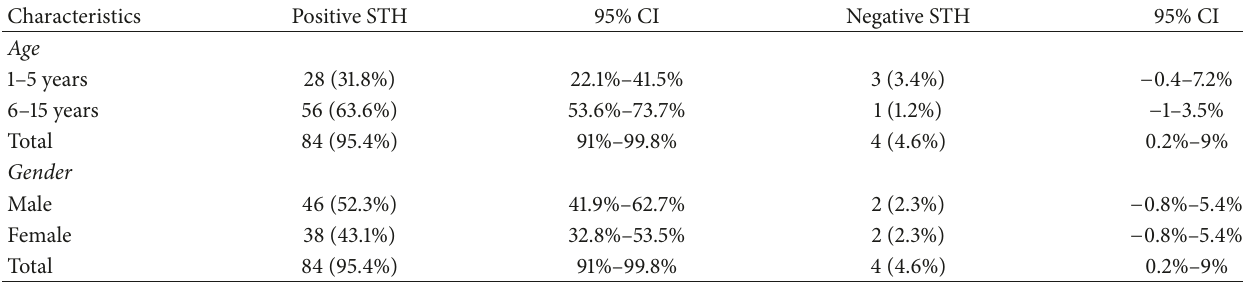
Table 1: The prevalence of STH prior to deworming based on age and gender.